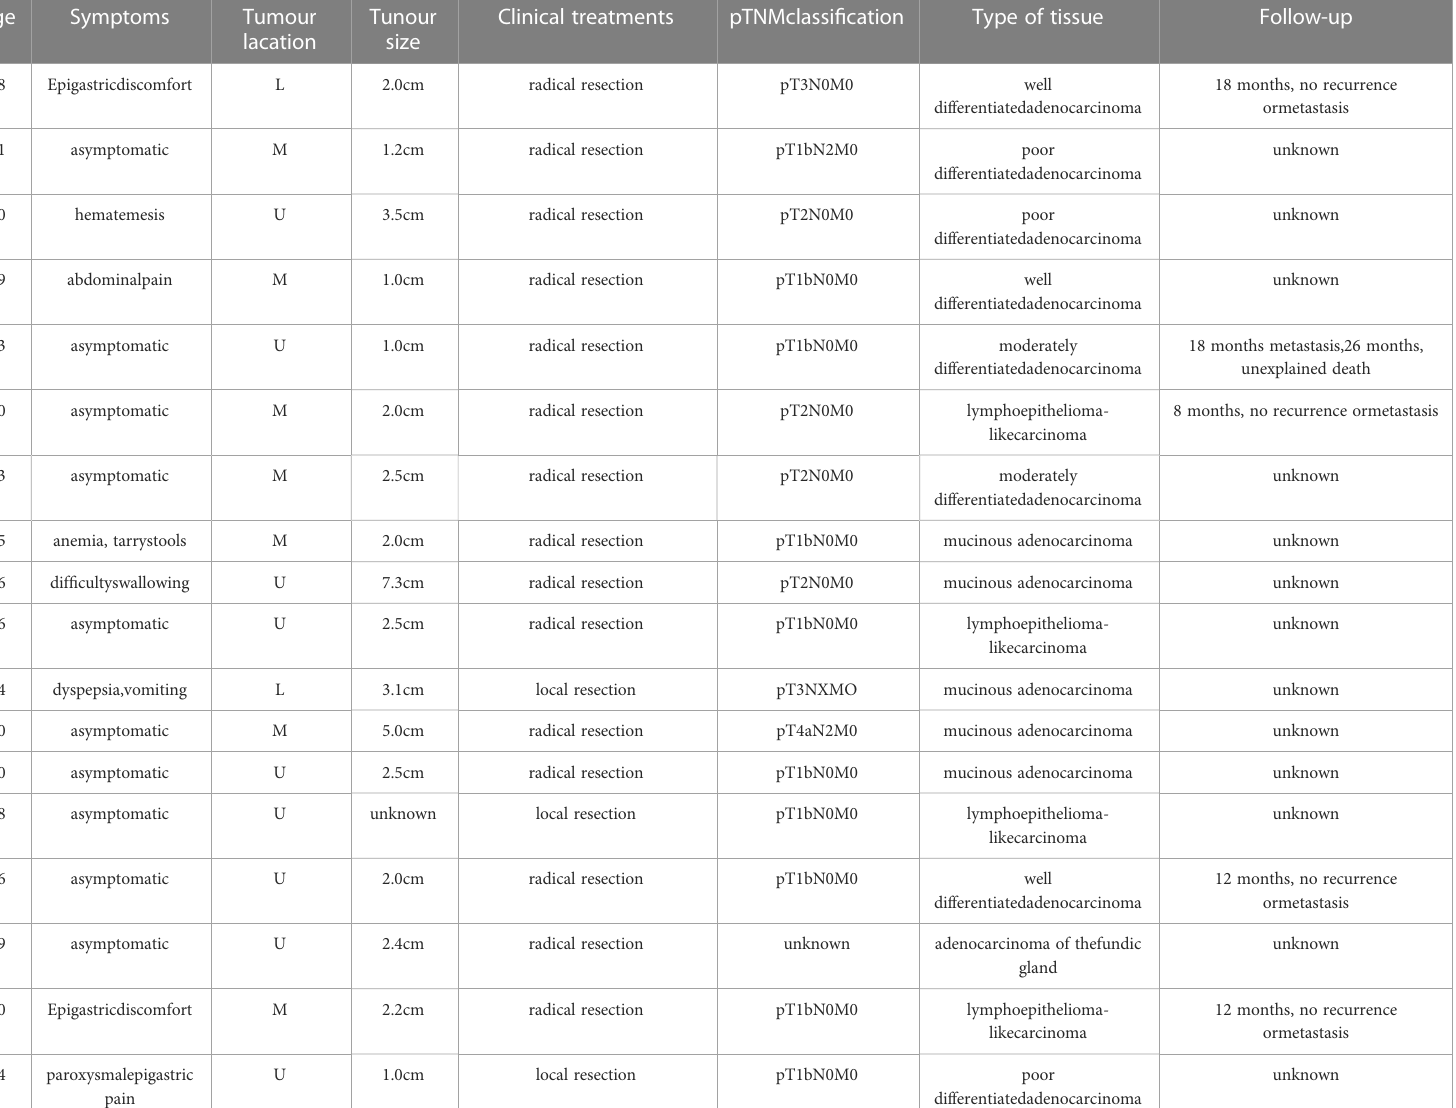
TABLE 2 Clinicopathological data of 31 patients with GCSMT.